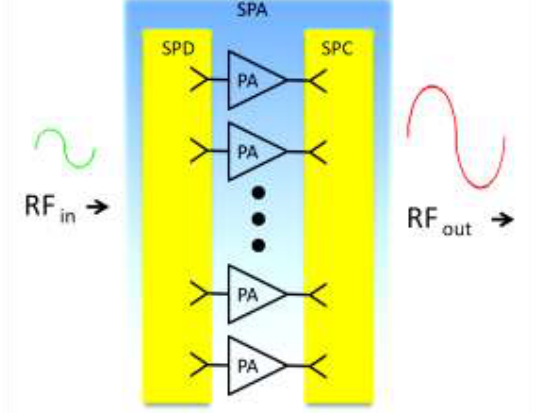
Figure 1: The general concept of Spatial Power